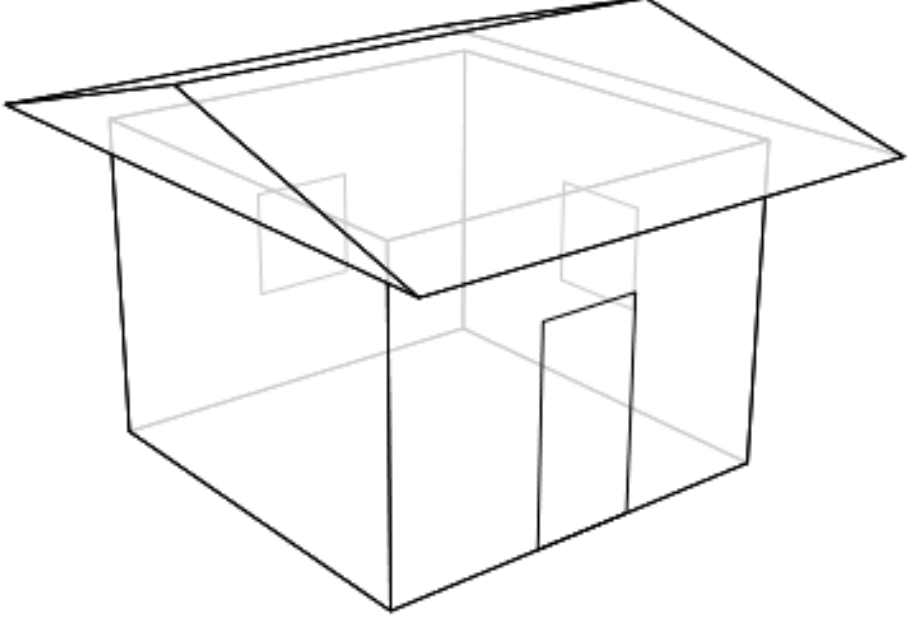
Figure 3. Axonometric view of the Building Information Model.